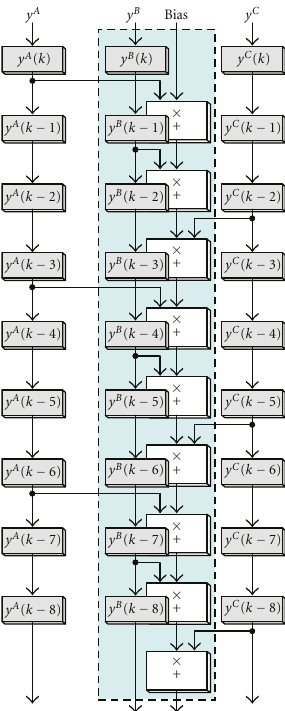
Figure 1: Data dependencies for a pipeline in naive architecture. Only the pipeline corresponding for the middle node is shown. White boxes represent functional blocks, consisting of a multiplier and an adder, while grey boxes represent registers. The middle node corresponds to a pixel sequence y B . For sequences y A and y C , functional blocks are dropped for clarity. Identical architecture is used to calculate the contribution of pixel inputs.